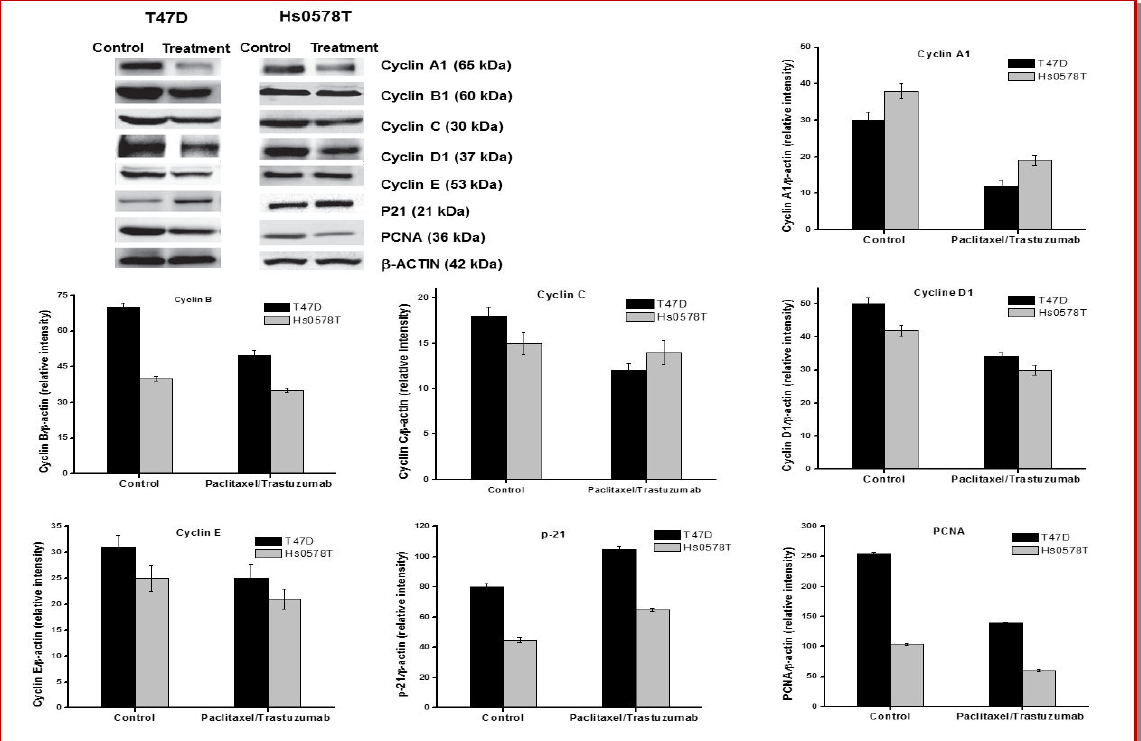
Figure 5: Cell cycle analysis of paclitaxel and trastuzumab treated T47D and Hs0578T cells. Total cell population was taken in to account to calculate number of cells in each cell cycle phase